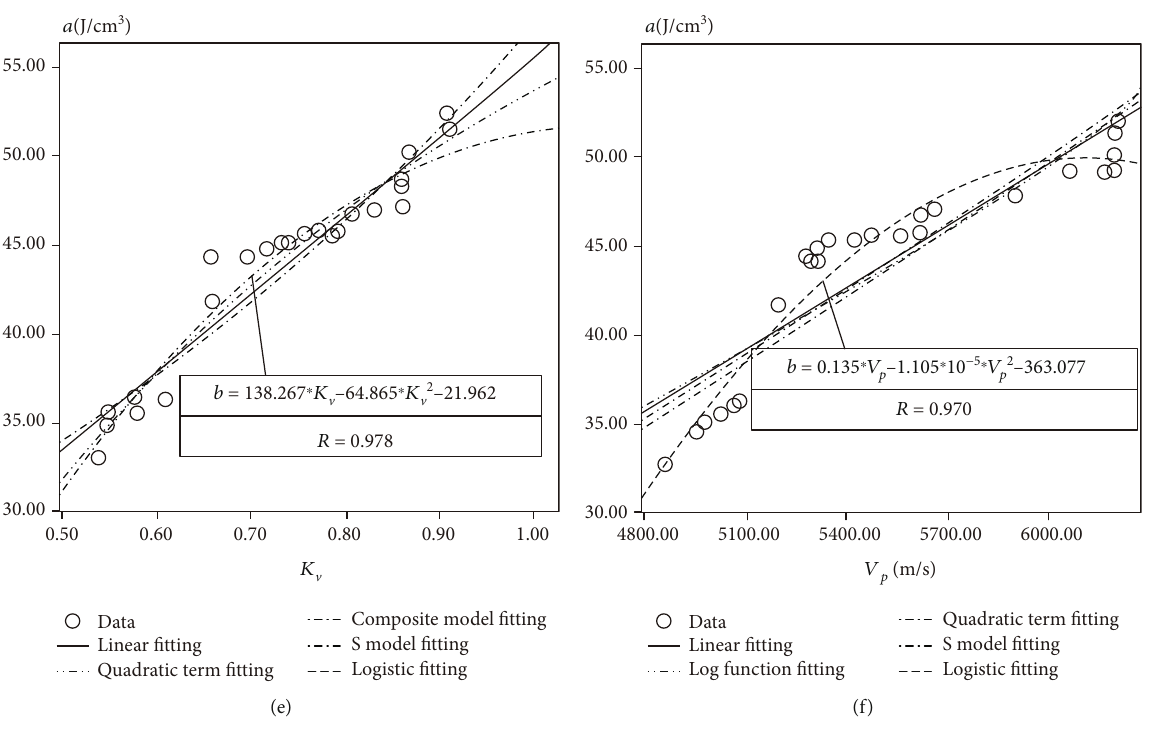
Figure 3: Chiseling speci fi c energy and mechanical parameter diagram.